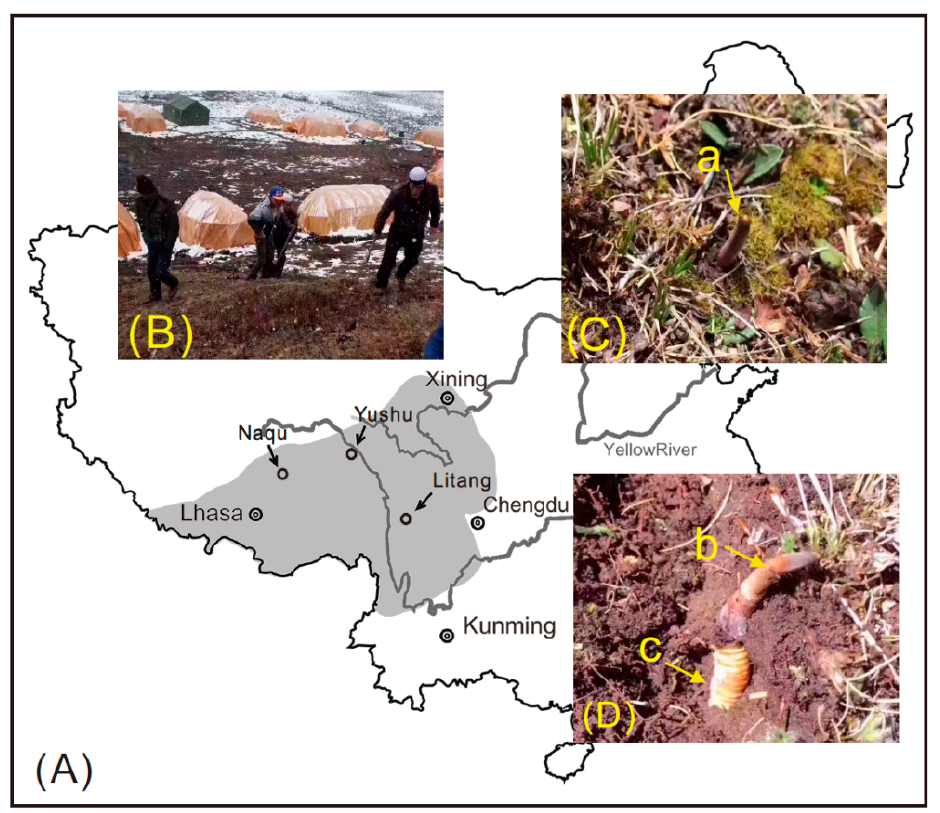
Figure 2. The producing area of Ophiocordyceps sinensis in China and sampling details of this study. ( A ) Schematic map illustrating the sampling sites in the Qinghai–Tibetan Plateau and its adjacent high-altitude areas. Litang (LT), Naqu (NQ), and Yushu (YS) were chosen as the sampling sites. ( B ) The grassland of the O. sinensis habitat. Pastoralists are encamped there to collect it. ( C ) The stroma (a) of O. sinensis emerged out of the ground. ( D ) O. sinensis in the soil, the yellow arrows pointing out its sclerotium (b) and stroma (c).